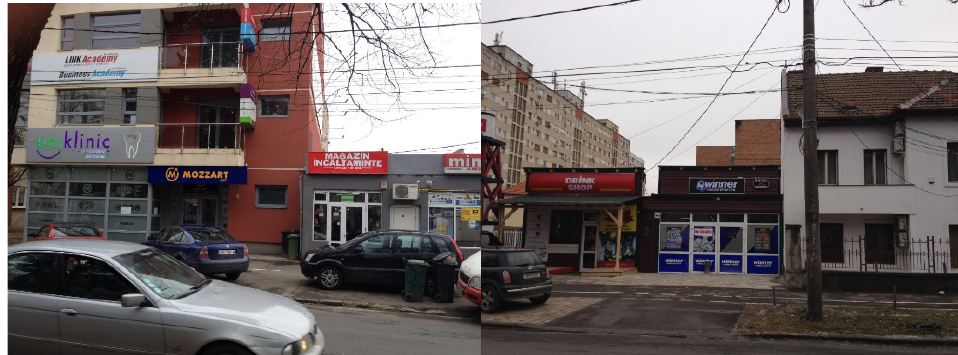
Figure 2: Mozzart (sports betting) , Eroilor de la Tisa Street 18 (left ); Winner (sports betting), Eroilor de la Tisa Street 18 (right) Source: Sorina VOICULESCU,